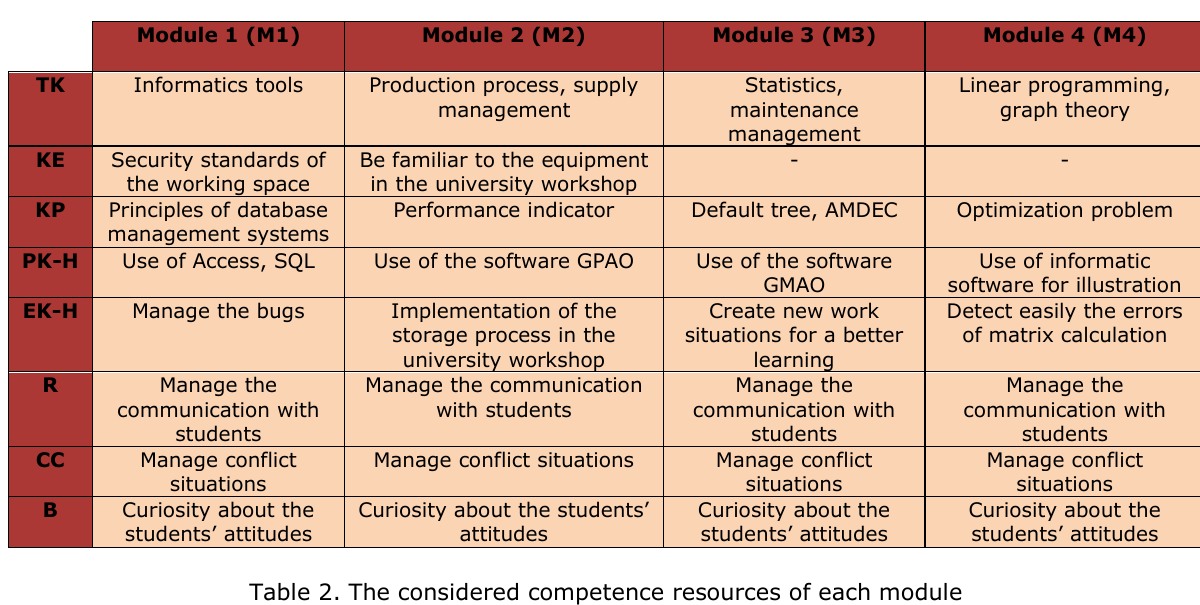
Table 2. The considered competence resources of each